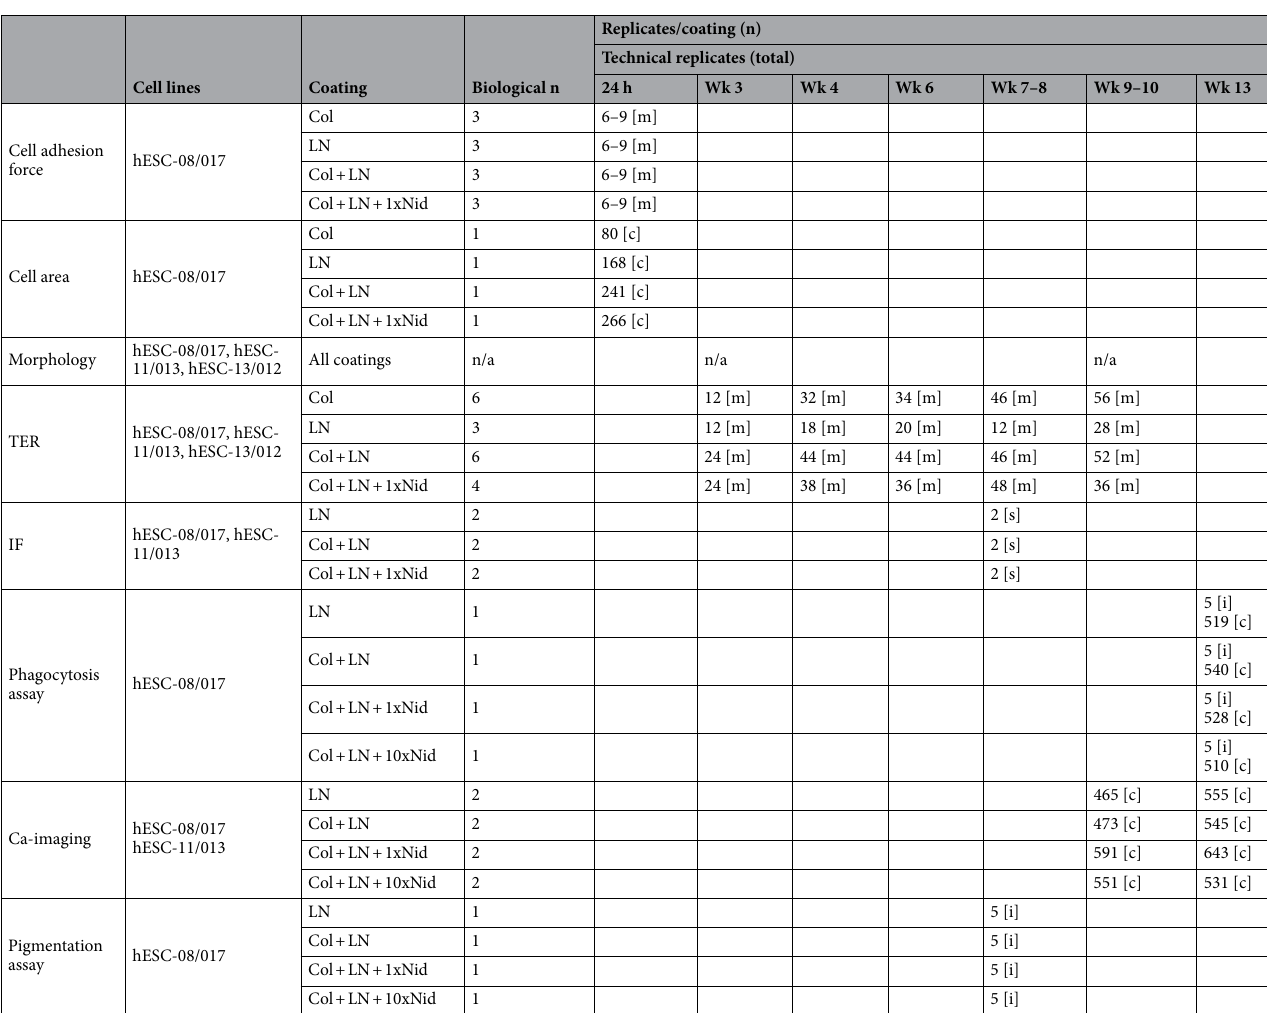
Table 1. Number of replicates for all experiments. [m] measurements, [c] cells, [s] stainings, [i] images, Col— collagen IV, LN—laminin,